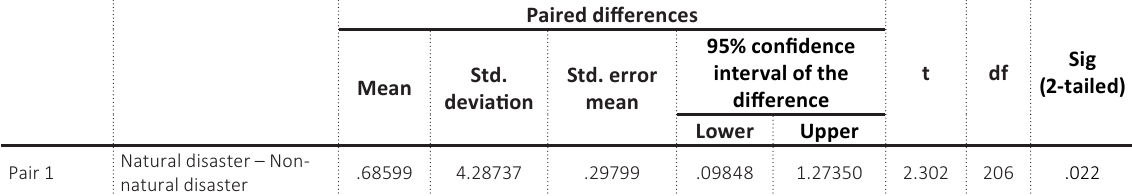
Table 3. Paired samples test